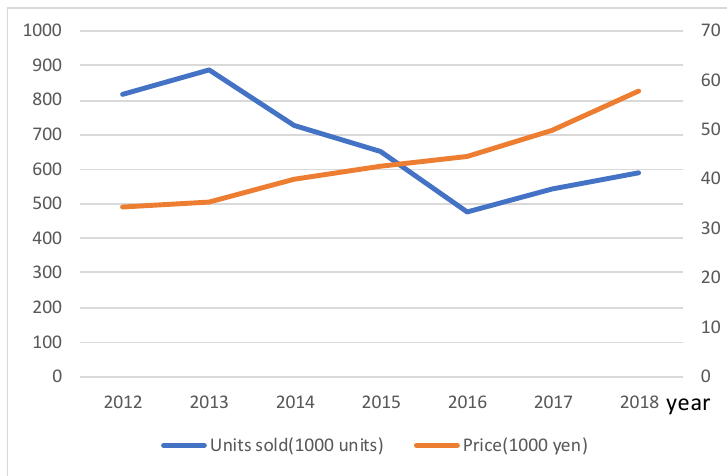
Figure 4. Units sold and price of DSLM